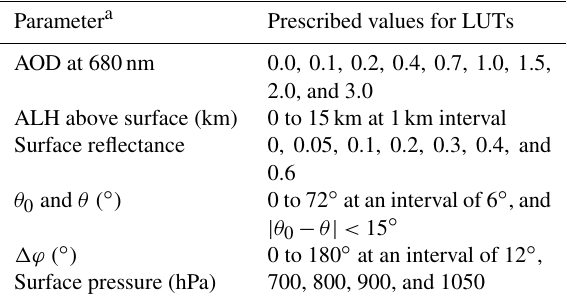
Table 1. Adopted parameters for generating